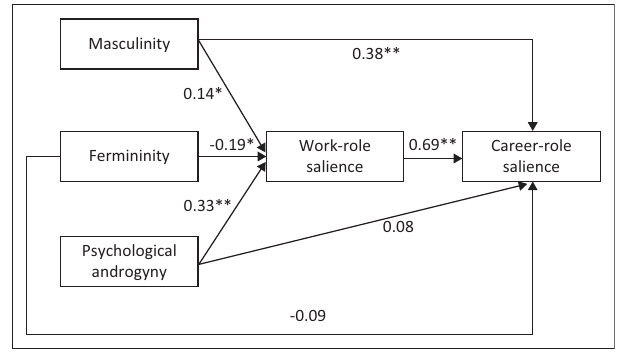
FIGURE 1: Direct and indirect